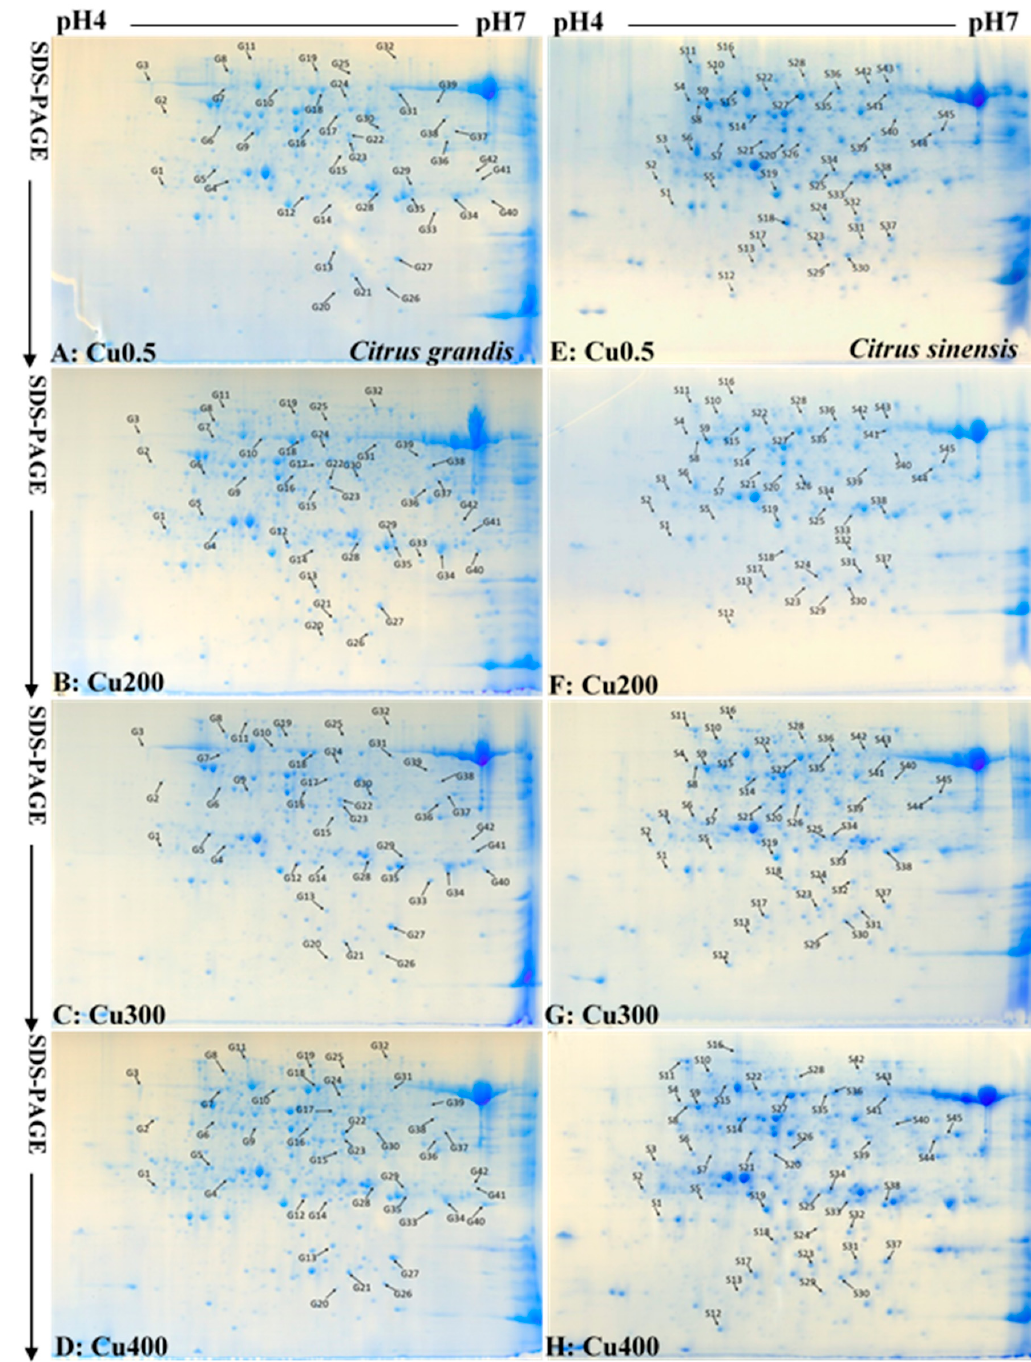
Figure 2. Representative 2-DE images of proteins extracted from 0.5 ( A , E ), 200 ( B , F ) 300 ( C , G ) and 400 ( D , H ) Cu-treated Citrus grandis ( A – D ) and Citrus sinensis ( E – H ) leaves.